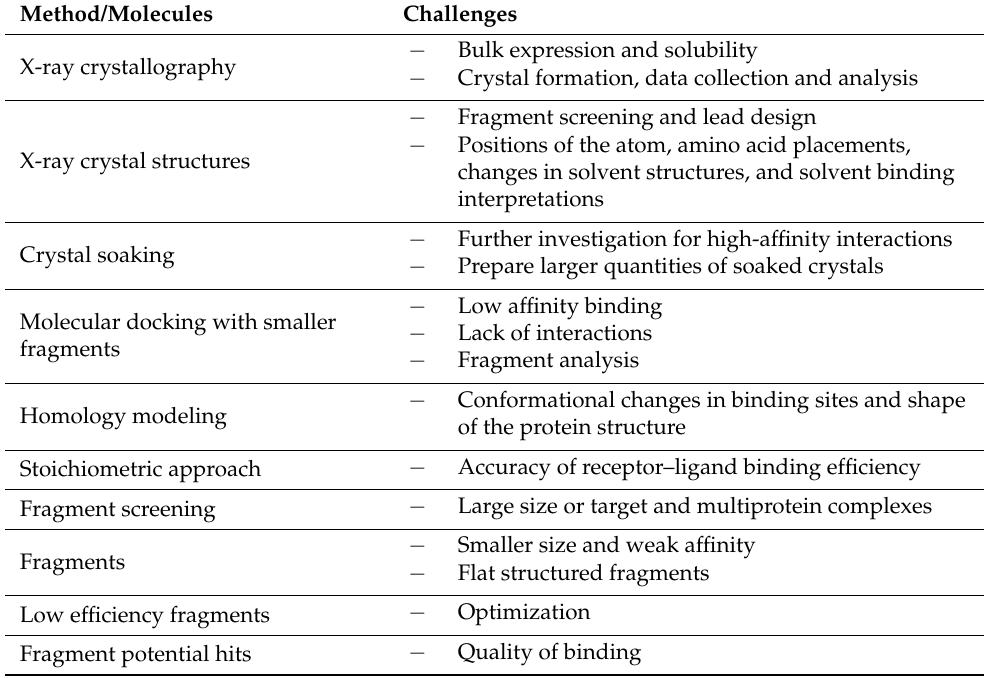
Table 3. Challenges in the FBDD